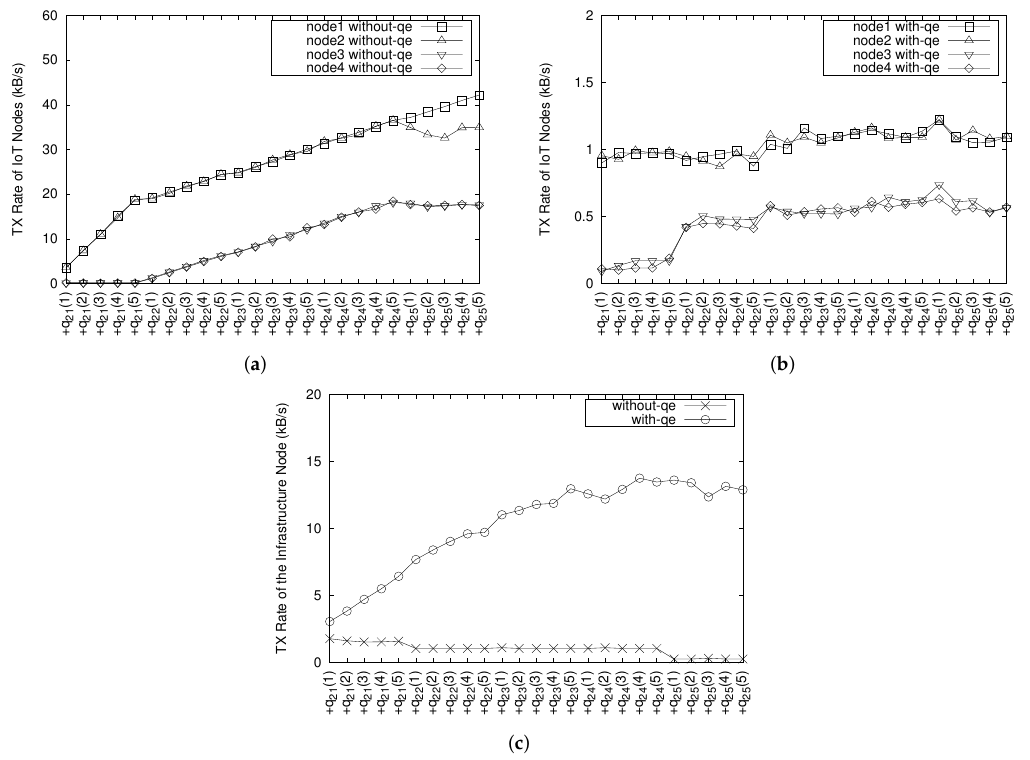
Figure 16. Network transfer rate. ( a ) IoT Node without QE; ( b ) IoT node with QE; ( c ) the infrastructure